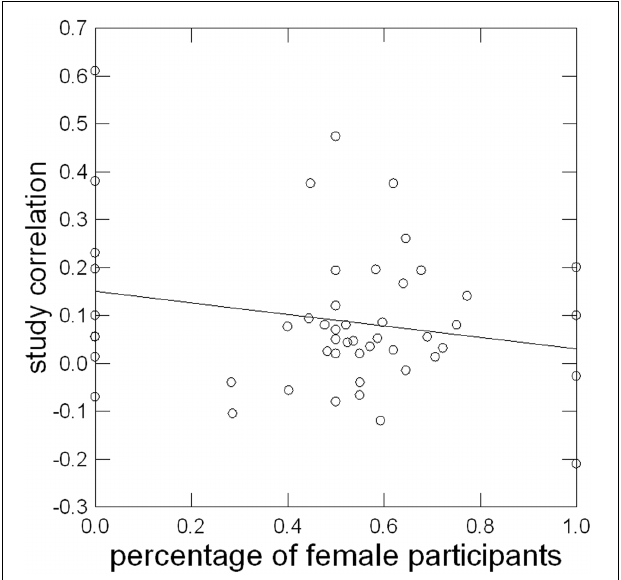
FIGURE 2 | Linear relationship of percentage of female participants in a sample with study correlation corrected for sampling error.